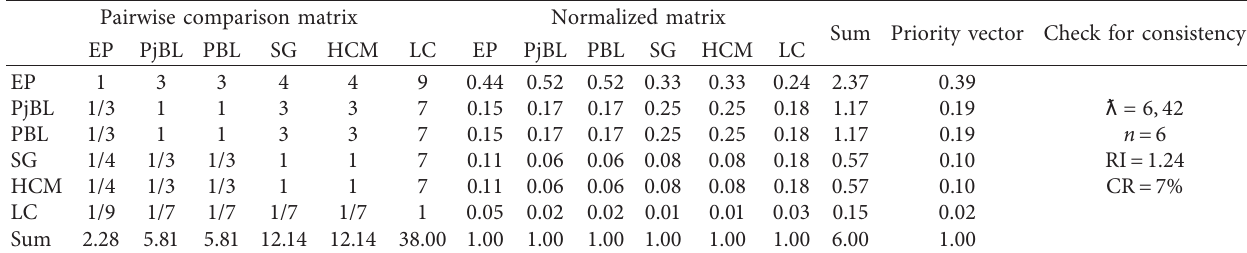
Table 16: Pairwise comparison matrix of learning strategies with respect to the Criterion “SS8. Team working.” Pairwise comparison matrix